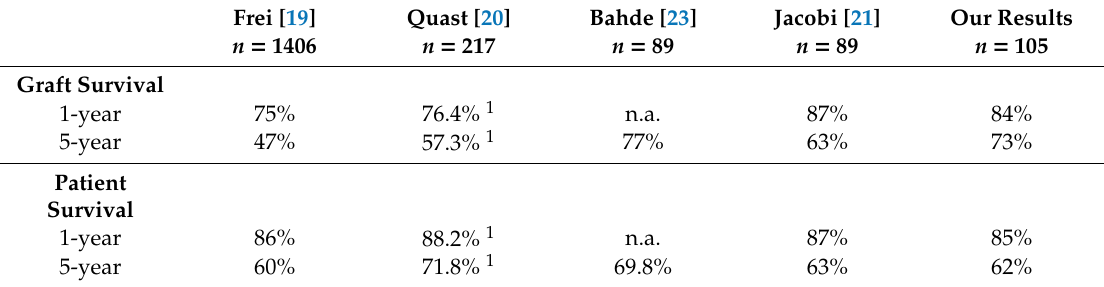
Table 6. Comparison of death-censored graft and patient survival in ESP programs. Frei